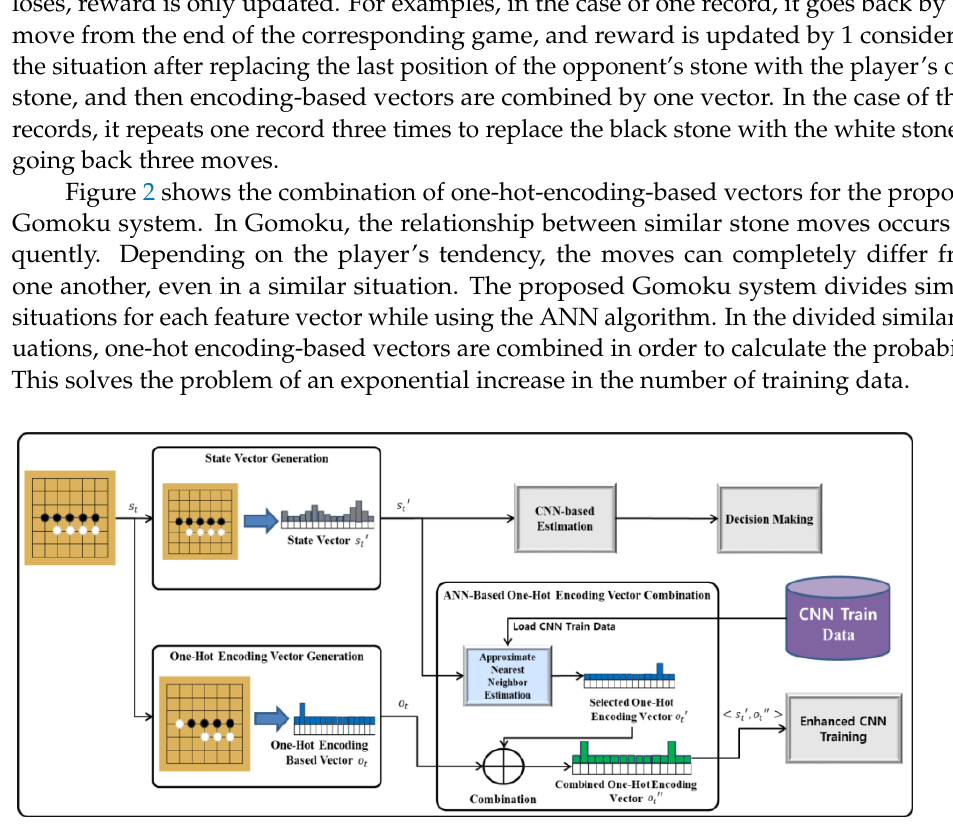
Figure 2. Approximate nearest neighbor (ANN)-based one-hot encoding vector combination.